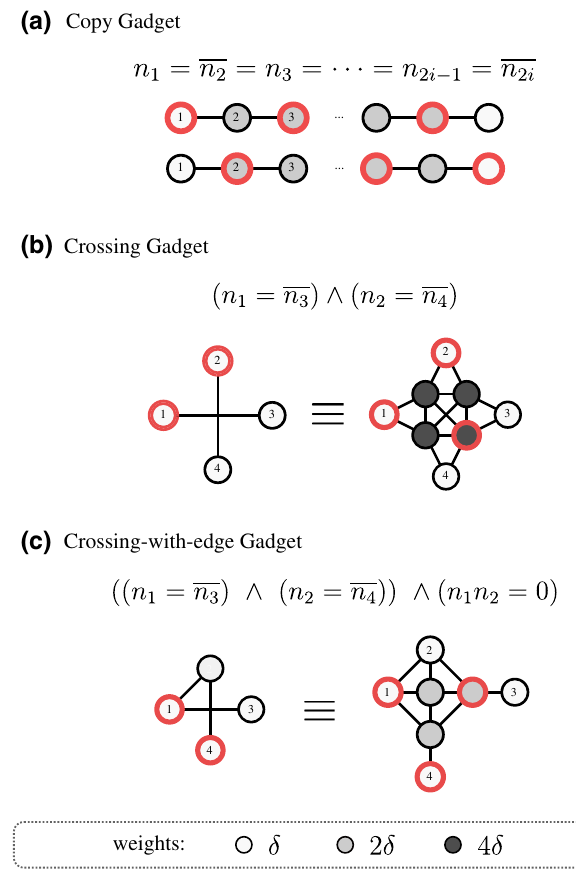
FIG. 4. Important gadgets for formulating constraint- satisfaction problems as UDG-MWIS. (a) Copy gadget. A 1D line graph encodes an effective bit. The two degenerate MWIS solutions are shown: the subset of odd-numbered vertices (top) and even-numbered vertices (bottom) represent the effective bit values 1 and 0, respectively. In this way, one can copy a single bit to any odd-numbered vertex. (b) Crossing gadget. The four degenerate MWIS solutions of the left graph coincide with the four MWIS solutions on the right graph on vertices 1, 2, 3, 4. One of these solutions is shown. Given a graph that contains a crossing, we can thus replace it with the right UDG, without changing the structure of the MWIS solution. (c) Crossing-with-edge gadget. Similar to (b), we can replace any subgraph of the type depicted on the left with the UDG on the right. One can check the MWIS solutions have one-to-one correspondence. The weights in (a)–(c) are encoded in grayscale according to the legend at the bottom of the